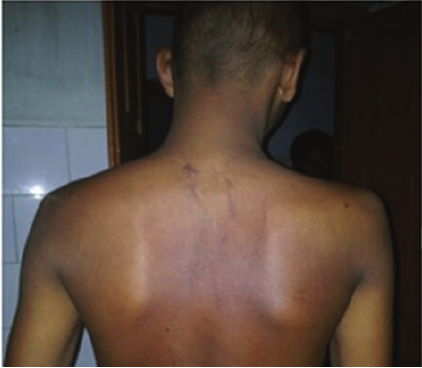
Figure 4: Clinical photograph showing reduced swelling after 3 cycles of